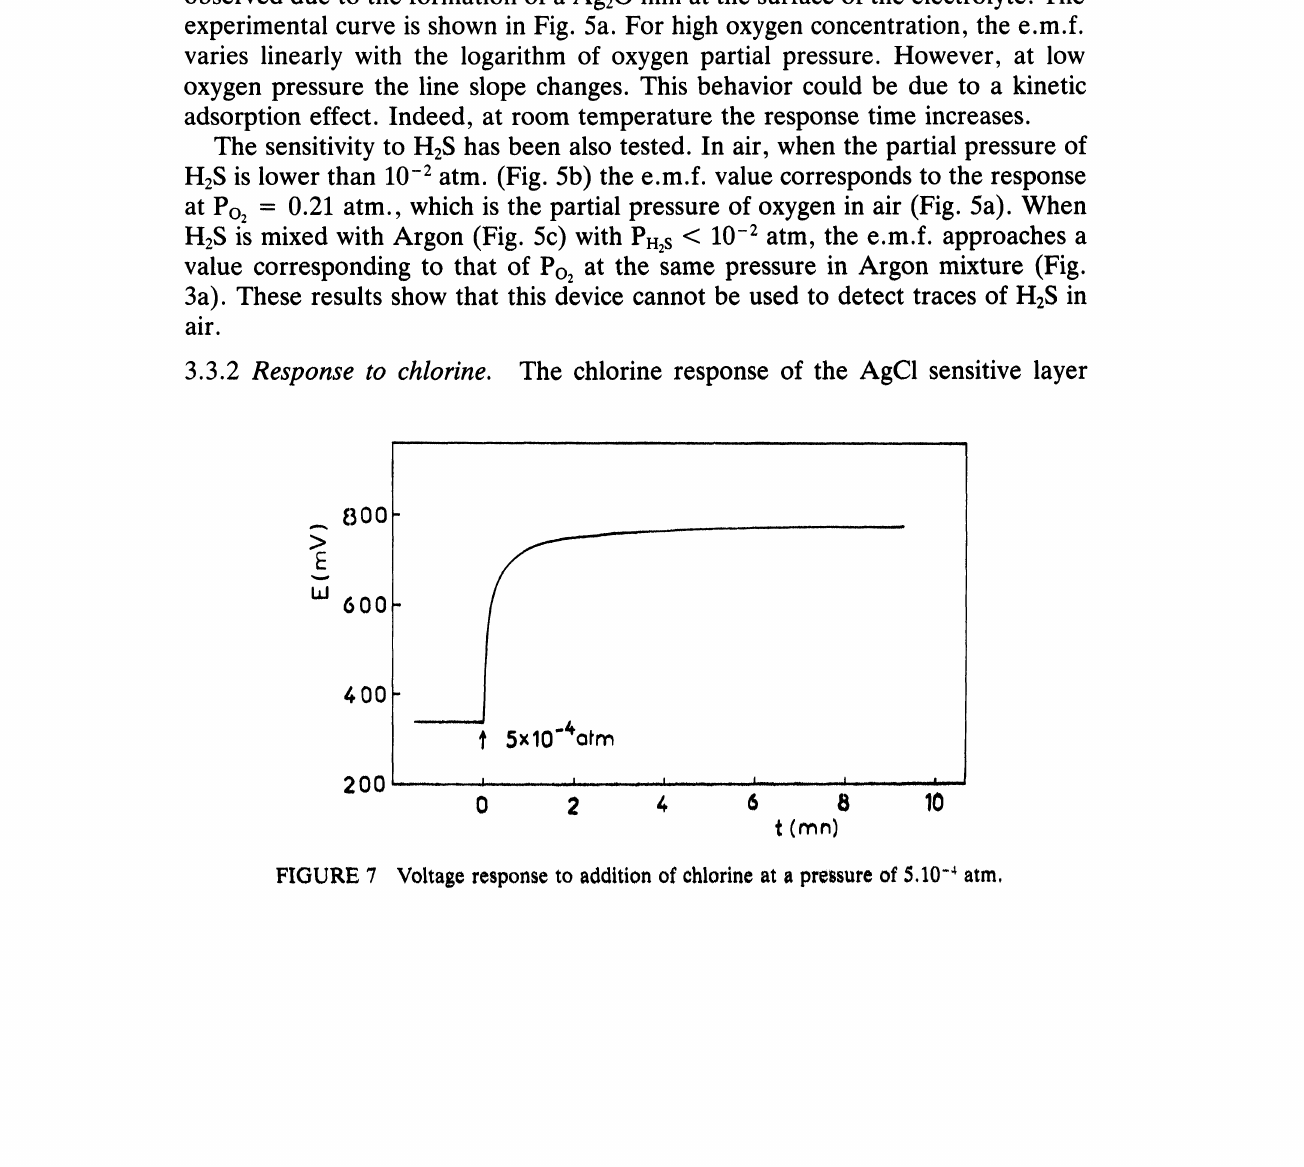
FIGURE 7 Voltage response to addition of chlorine at a pressure of 5.10